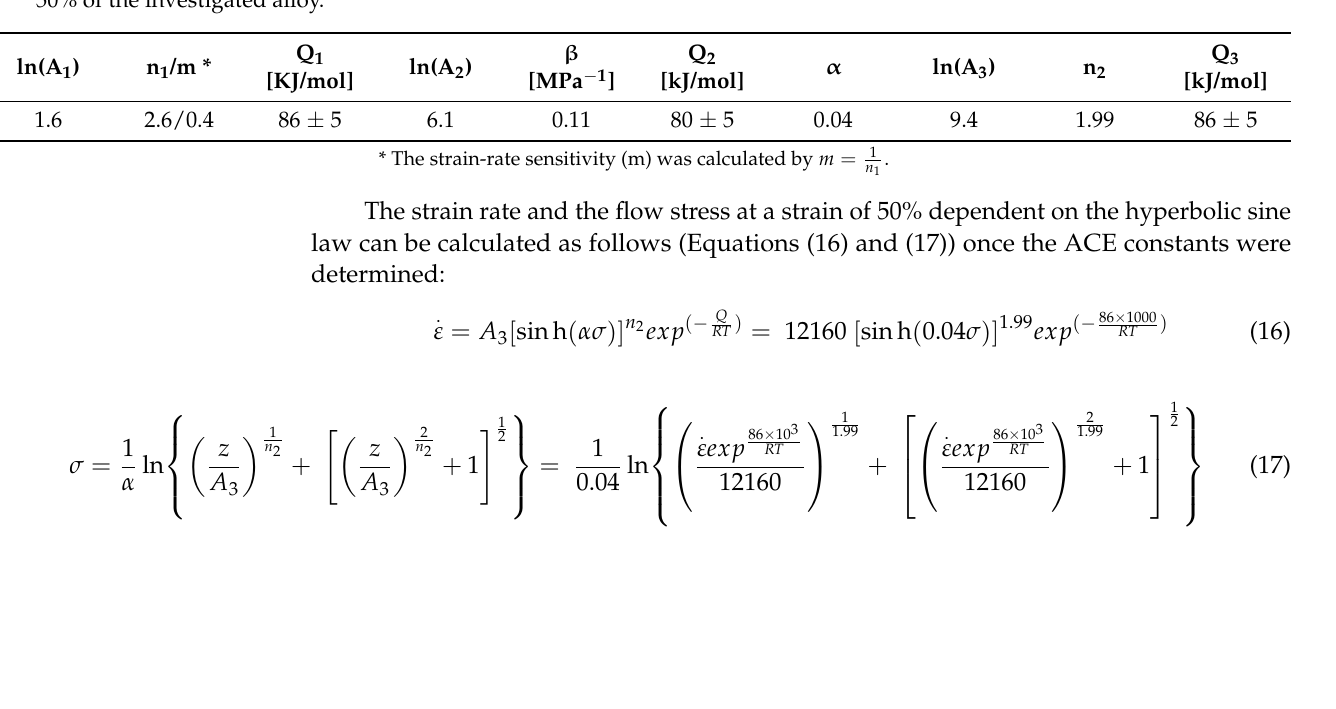
corresponding to a strain RT